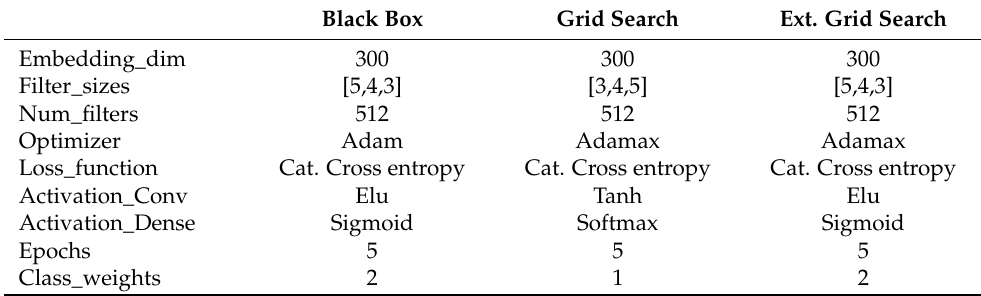
Table 3. Best hyperparameter configuration for CNN. Black Box Grid Search Ext. Grid Search 300